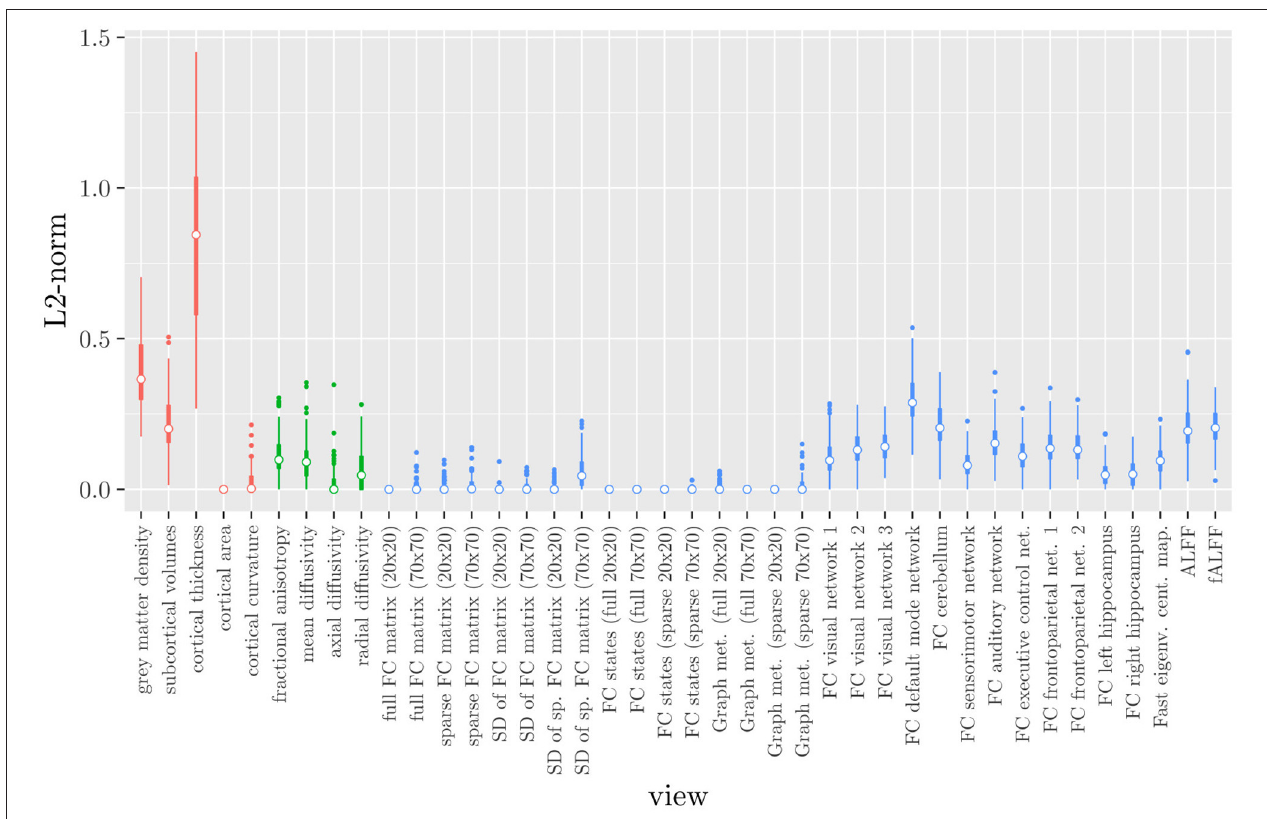
FIGURE 2 | Boxplots of the L 2 -norm of the regression coefficient vector for each MRI measure resulting from the elastic net regression, colored by scan type (red = structural MRI, green = diffusion MRI, blue = resting state